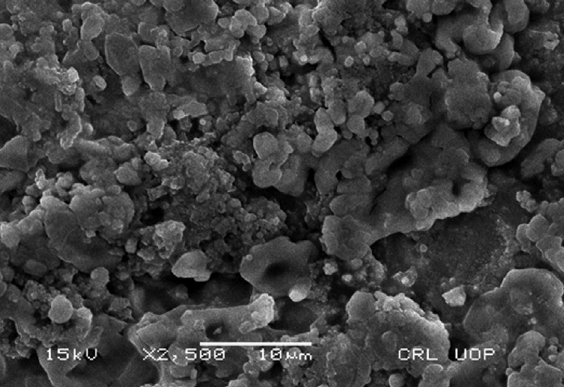
Figure 8: SEM image of biologically synthesized silver nanoparticles by Diospyros lotus leaf